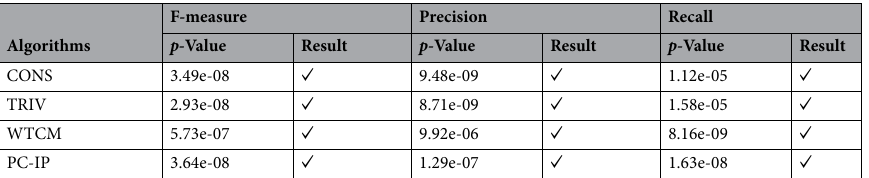
Table 2. Results of t-test for comparing the performance of LA-IP versus other algorithms in terms of F-measure. “ ✓ ”, “ ✗ ”and “~ ” indicate that the performance of the LA-IP is better than, worse than, or similar to that of the compared algorithm, respectively, at a 0.05 level of significance by